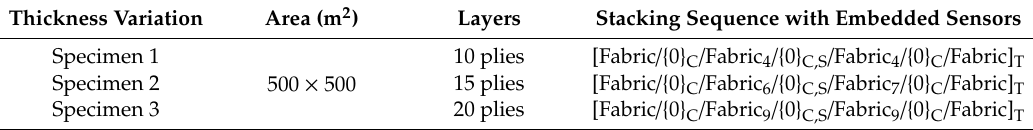
Figure 3. Configuration of composite specimens with sensor locations. Table 1. Information on the composite laminates and the insertion of fiber Bragg grating (FBG) sensors.